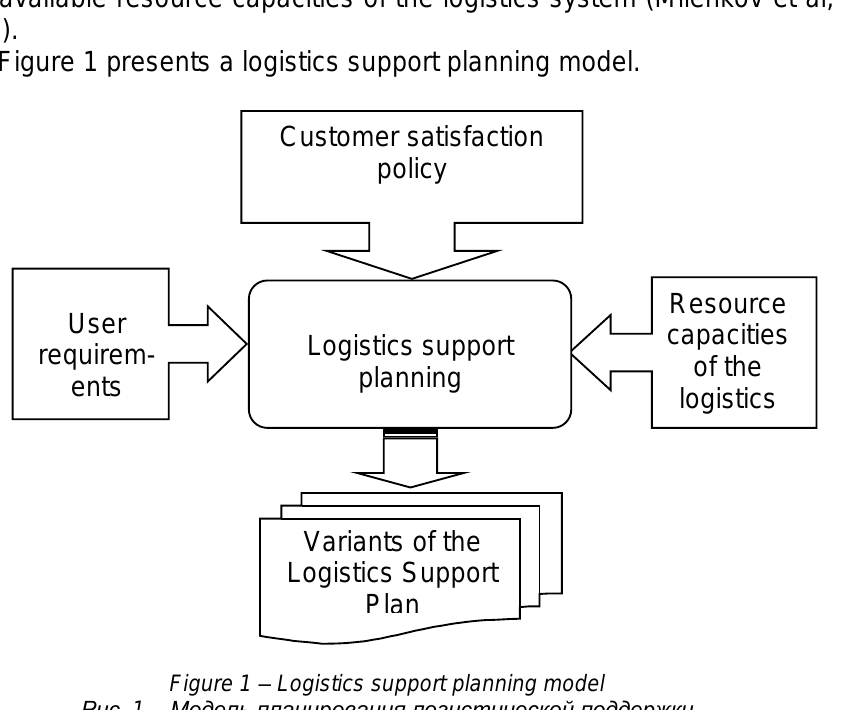
Figure 1 – Logistics support planning